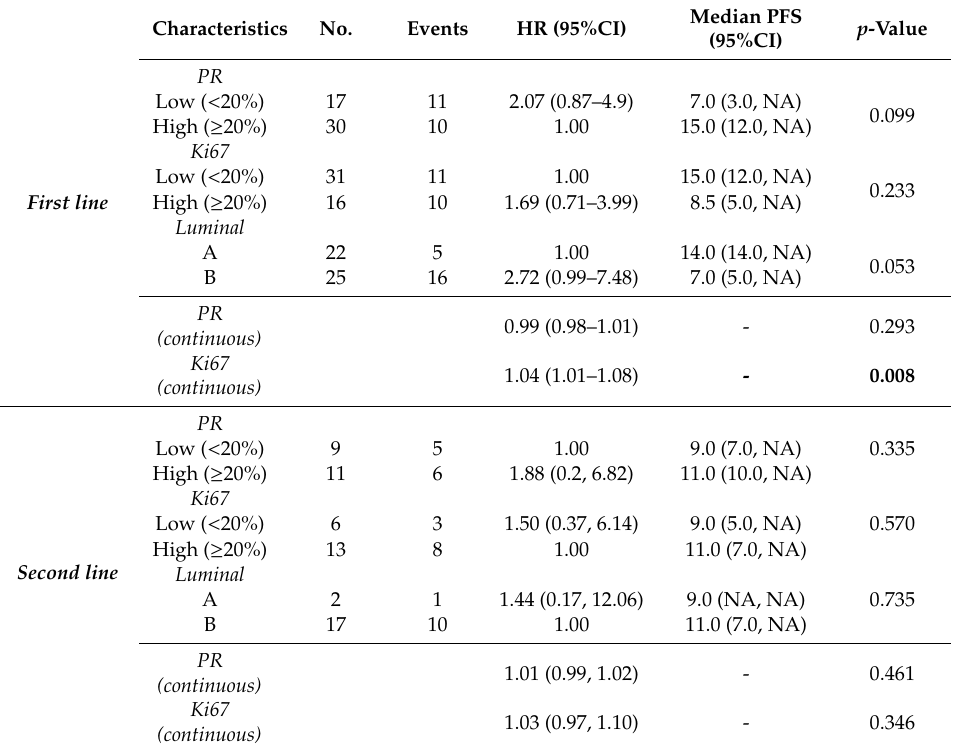
Table 2. Univariate analysis.